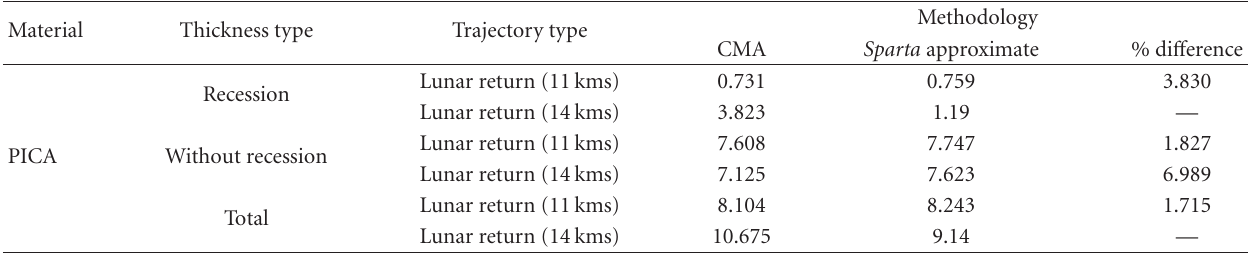
Table 10: Stagnation Point TPS Recession thickness and in-depth thermal response comparison.